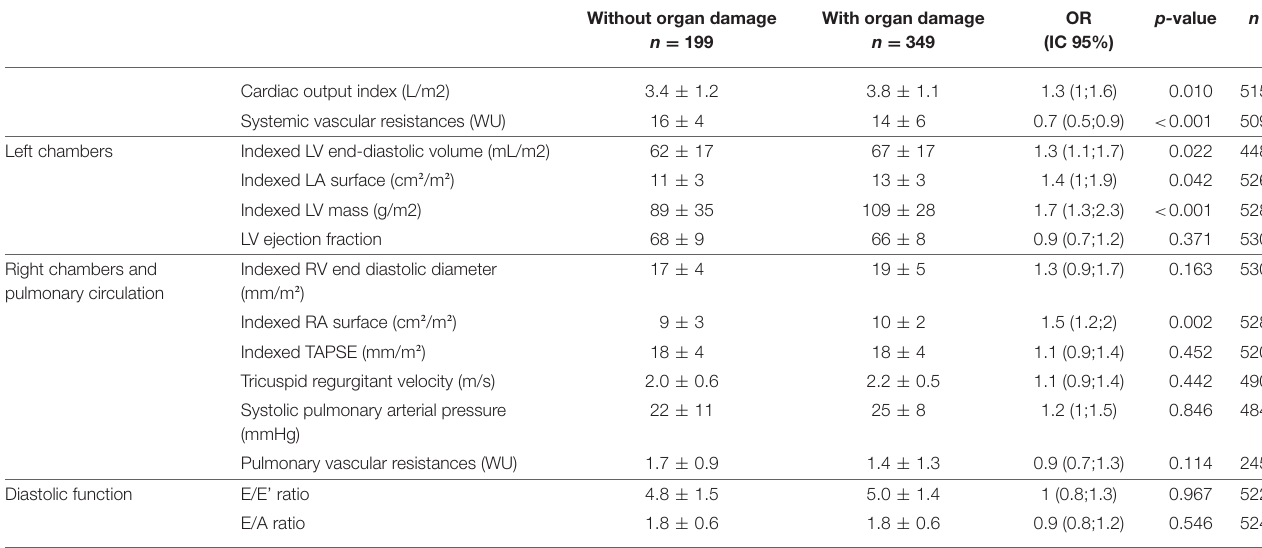
TABLE 3 | Multivariate associations between SCD-related extra-cardiac organ damage and echocardiographic measurements, adjusted for age, mean blood pressure, heart rate, hemoglobin, phenotype of hemoglobin and country.